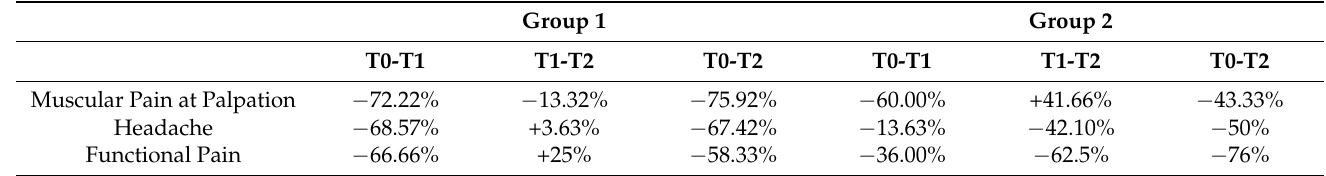
Table 3. Intra-group differences expressed in percentage for both the groups. Group 1 Group 2 T0-T1